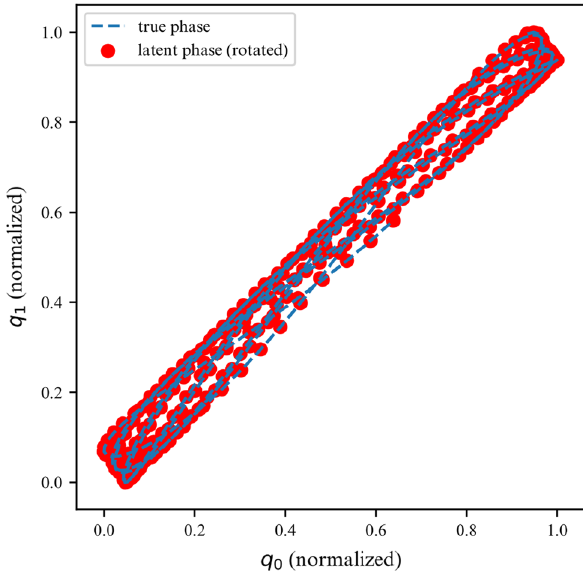
Figure 8. Phase space for first DOF of a linear 2DOF